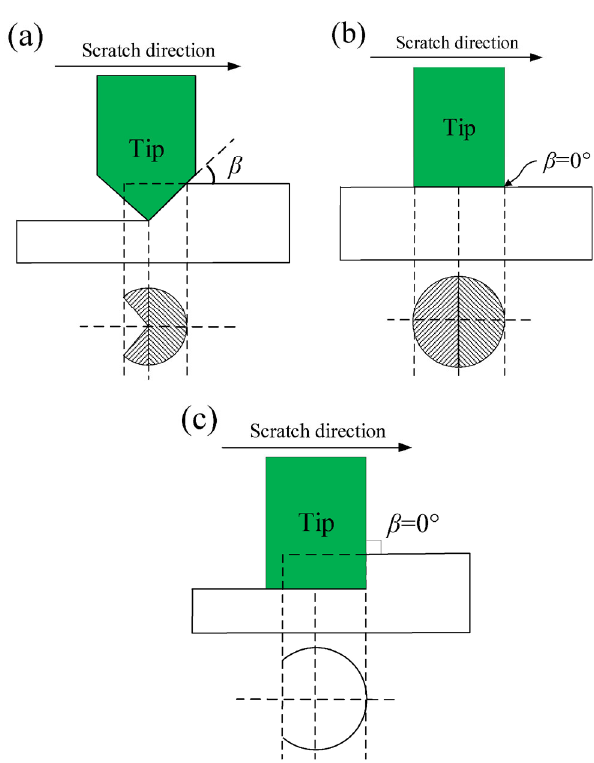
Fig. 3 Schematic of the conical tip-polymer substrate systems with different attack angle  : (a) 0° <  < 90°, (b)  = 0°, and (c)  = 90°.